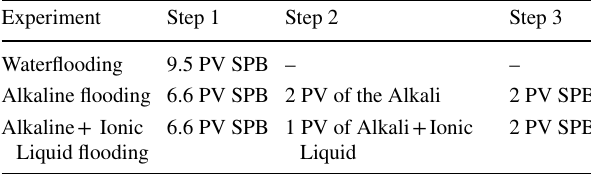
Table 2 The procedure of the experimental results Experiment